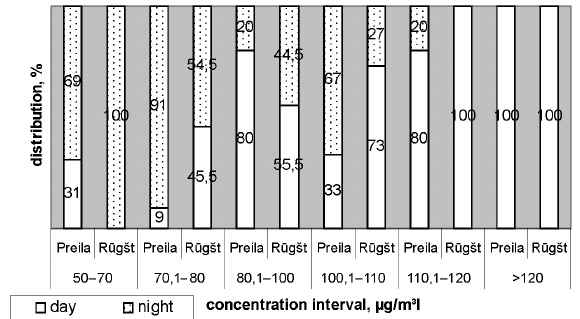
Fig 3. Distribution of cases with occluded front at differ- ent ozone concentration intervals in Preila and R ū gšte- lišk ė s during day and night